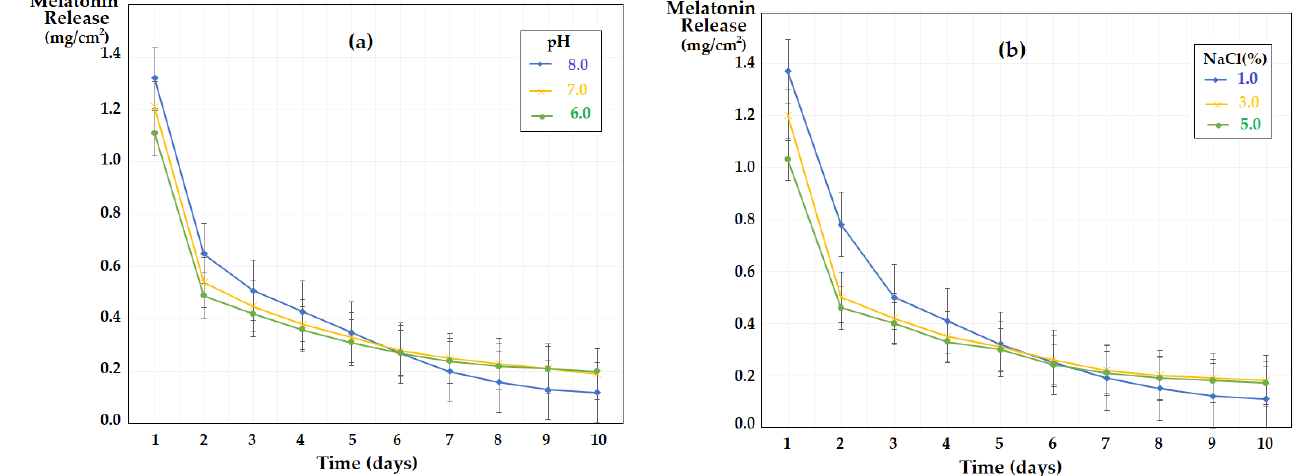
Figure 17. The variation of the amount of melatonin delivered daily per surface unit (cm 2 ) of melatonin-chitosan-sulfonated ethylene-propylene-diene terpolymer composite membranes (Mel-Chi-sEPDM, M3), over a period of 10 days: ( a ) depending on the pH and ( b ) the salinity of the receiving phase.